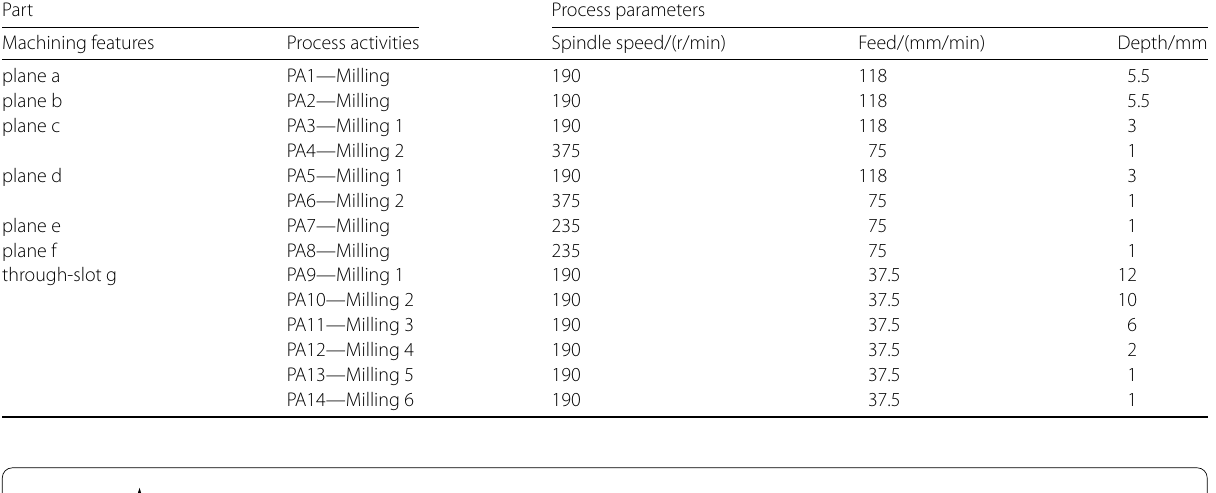
Table 1 The machining data of machine tool center stand base Part